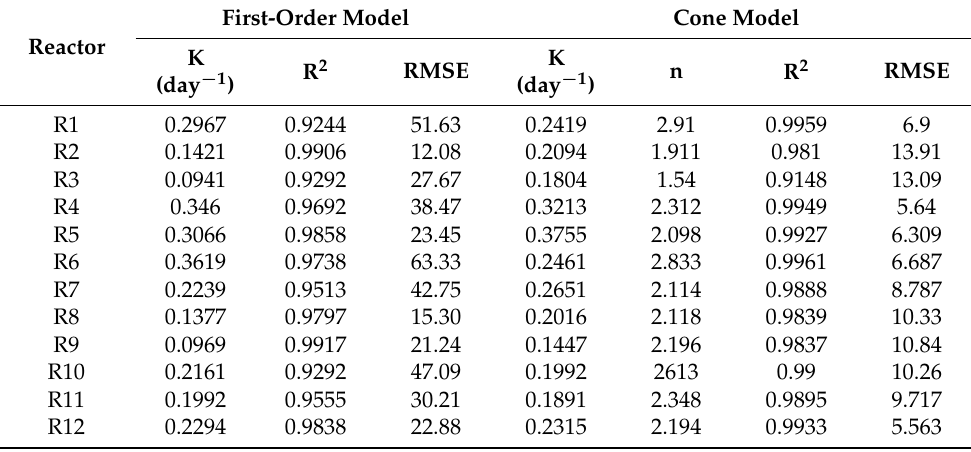
Table 4. Results of the study using first-order kinetic and cone